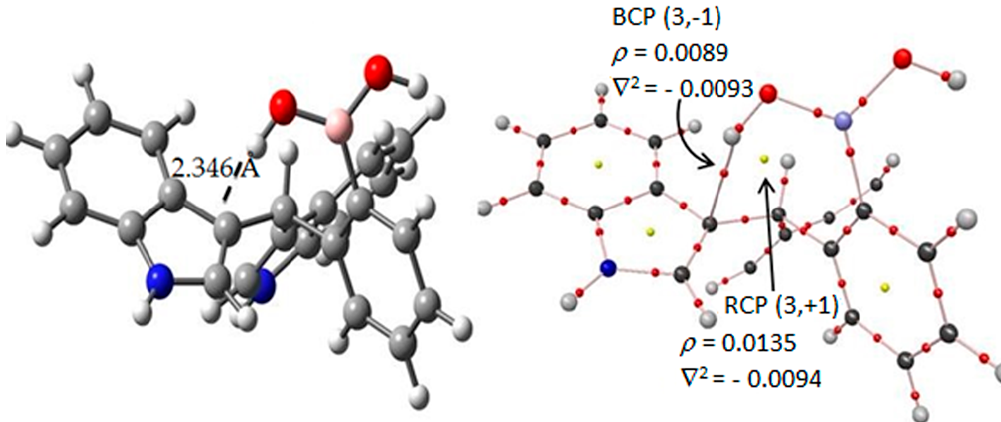
Figure 4. AIM results of the hydrogen–C3 ′ interaction in the tt - I diindolylmethane-phenylboronic acid hybrid. Molecular graphs for tt - ortho -regioisomer interaction. Density ρ ( r ) and its Laplacian ∇ 2 ρ (r) at the BCPs characterizing the HB interactions. The gray, blue, pink, red and white spheres are for carbon, nitrogen, boron, oxygen and hydrogen atoms respectively.